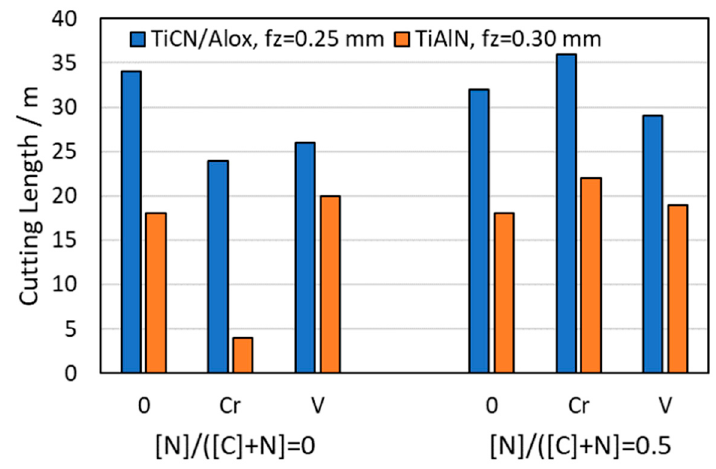
Figure 13. Cutting tests of low C activity grades with two different coatings (CVD-Ti(C,N)/ Al 2 O 3 , PVD-(Ti,Al)N), at two different [N]/([C]+[N]) ratios of the added TiC/TiN phase as a function of doping.